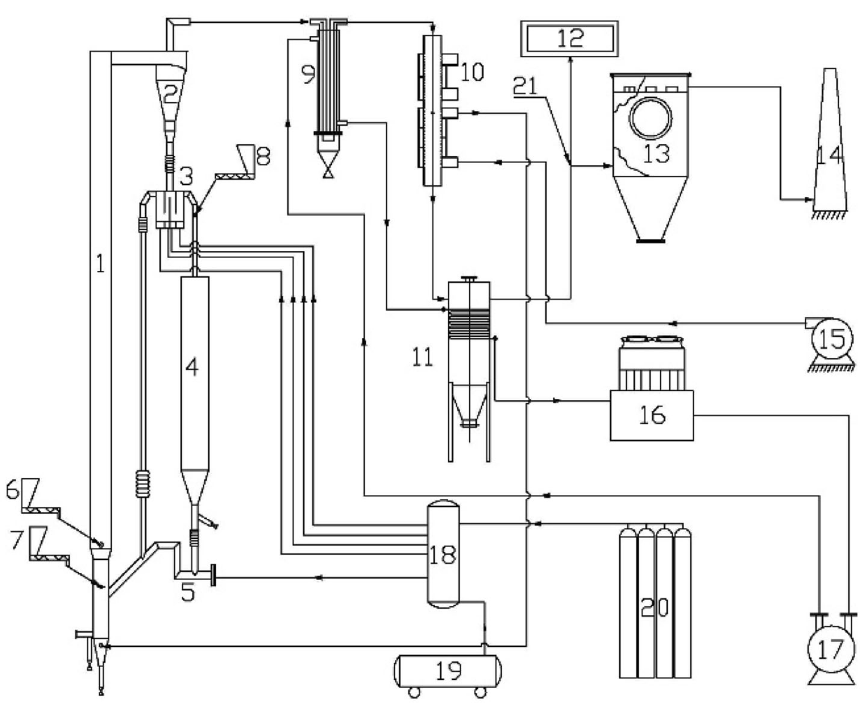
Fig. 1 Schematic diagram of the test rig (Yu 2012). 1 —gasifier; 2 —cyclone; 3 —upper loop seal; 4 —pyrolyzer; 5 —lower loop seal; 6 —screw